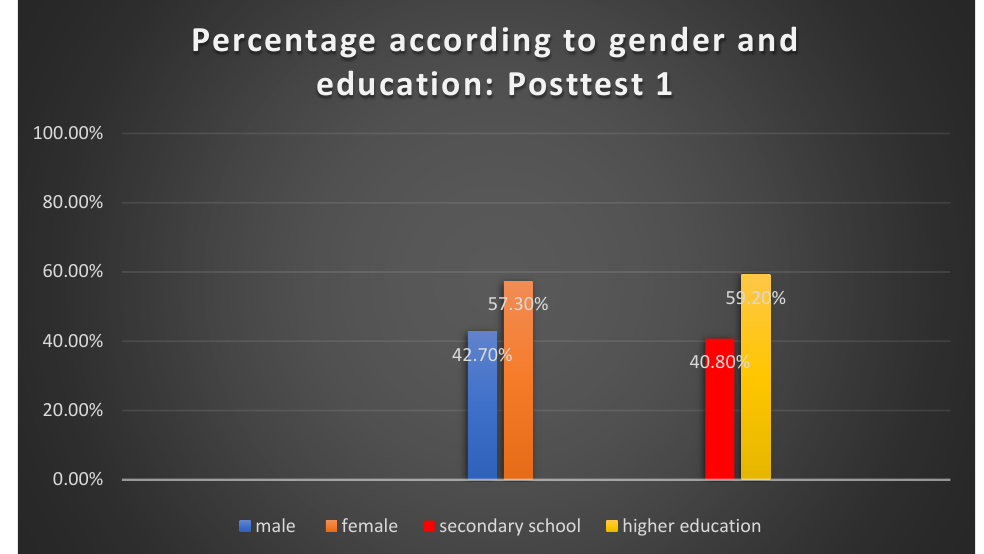
Table 10. Posttest 1 results regarding gender and level of education.